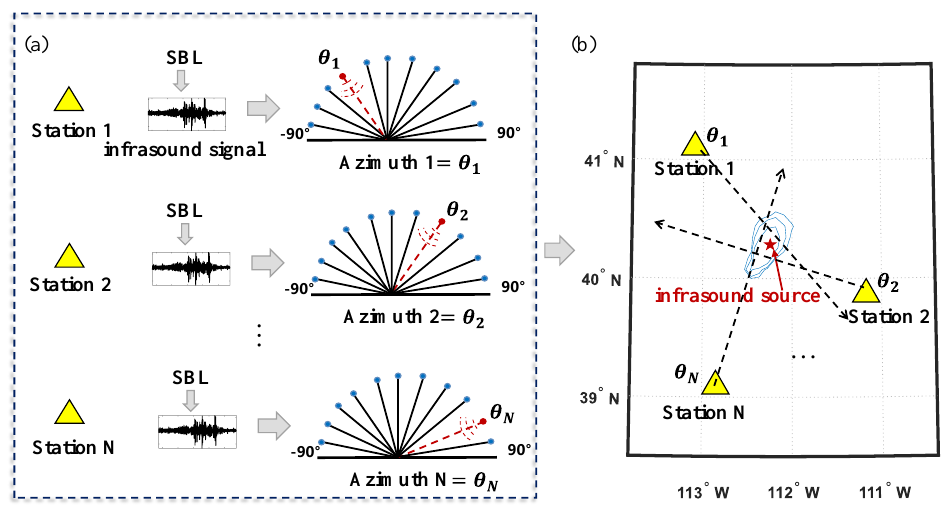
Figure 4. The schematic diagram for Bayesian information fusion algorithm. ( a ) SBL:SBL-based infrasound signal processing of stations to obtain the azimuth of stations (azimuth = θ 1 , θ 2 , . . . , θ N ); ( b ) Bayesian information fusion:information fusion of station-acquired azimuths using Bayesian information fusion to obtain localization results (red pentagrams indicate localized infrasound source locations, yellow triangles indicate infrasound stations,and the three blue contour lines are credibility curves with different Bayesian credibility